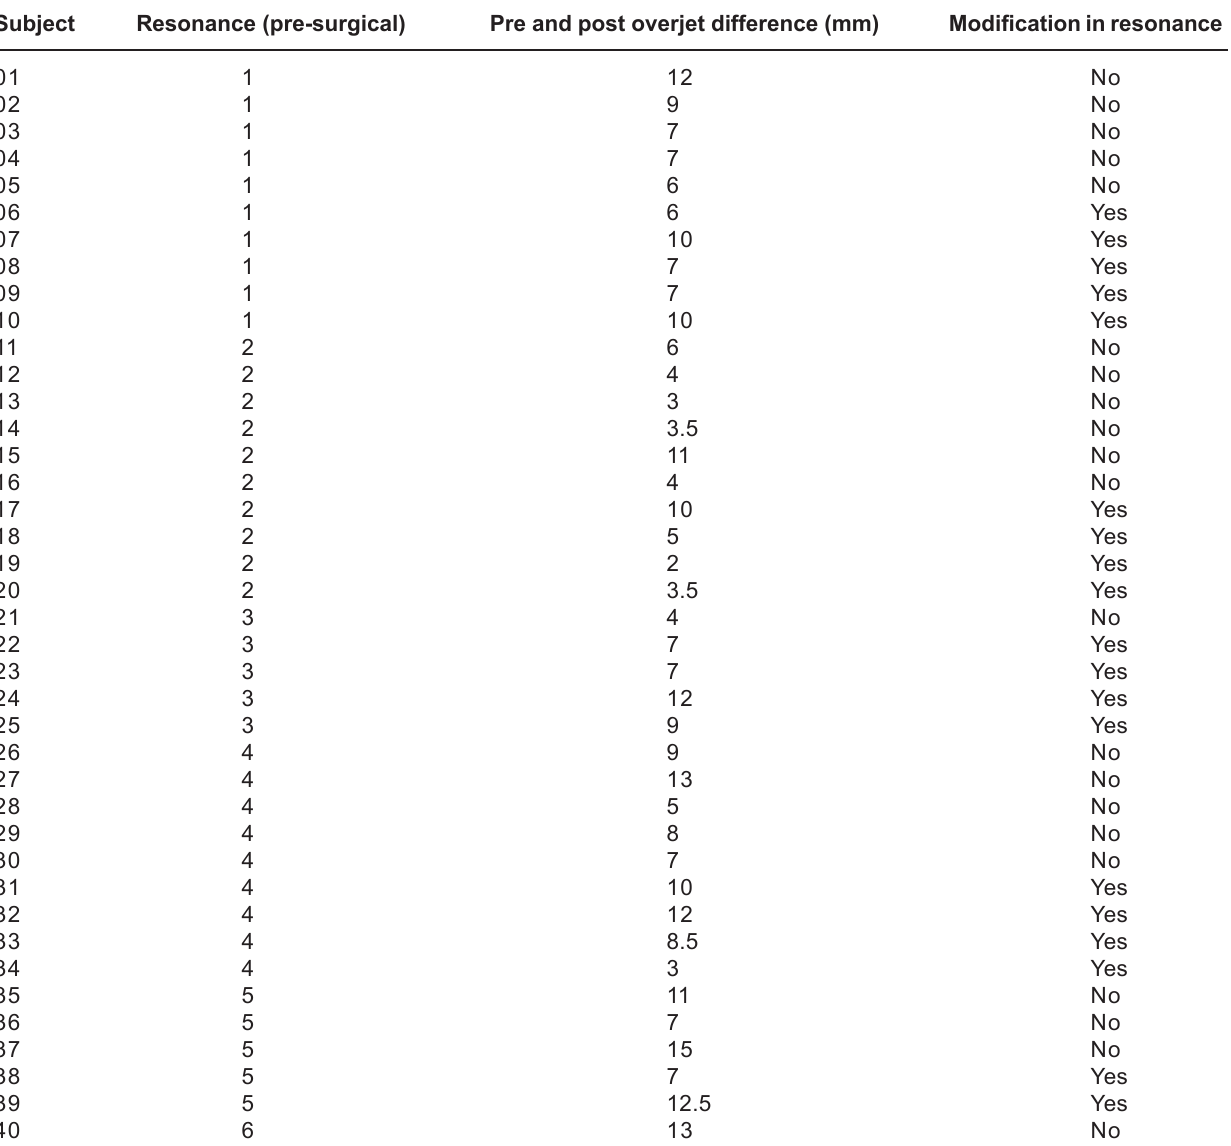
TABLE 1- Relation between pre and post-surgical overjet difference and resonance modification after